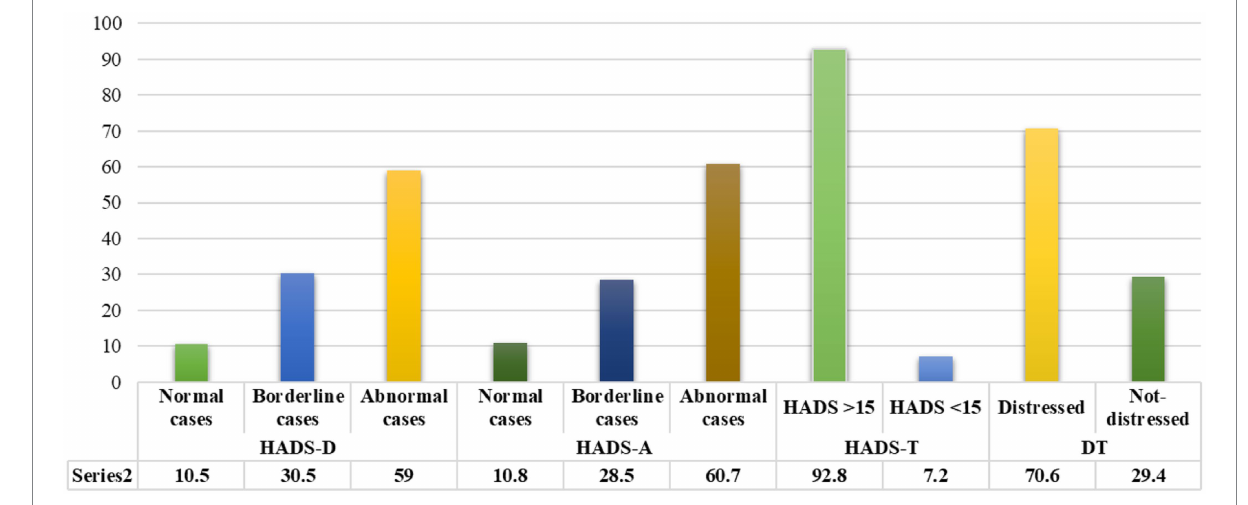
FIGURE 1 Frequency of distress among Palestinian advanced cancer patients ( N =